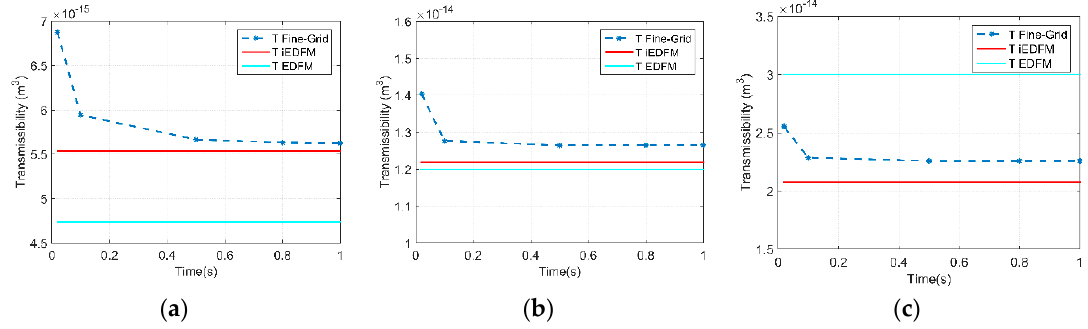
Figure 5. T M-F of the fine-grid model (equivalent)/iEDFM/EDFM for block ( a )/( b )/( c ). The equivalent transmissibility calculated by the fine-grid model will change over time until the flow approaches a steady state, while the ones calculated through the pre-processing procedure of iEDFM/EDFM stay the same.